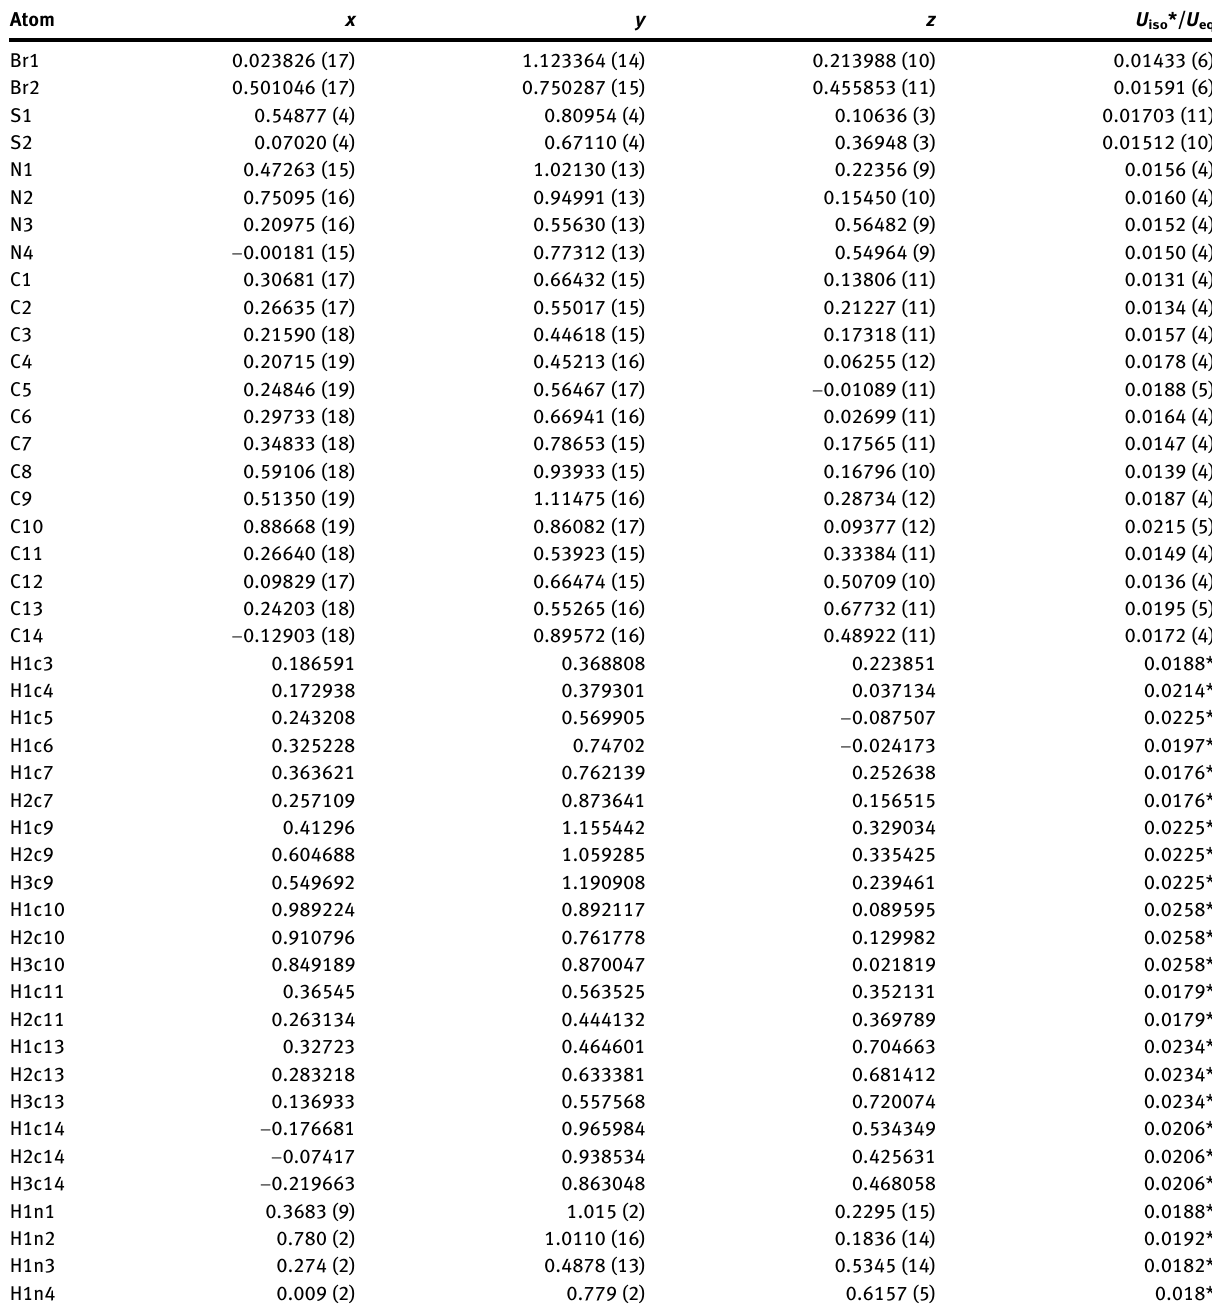
Table  : Fractional atomic coordinates and isotropic or equivalent isotropic displacement parameters (Å  ).